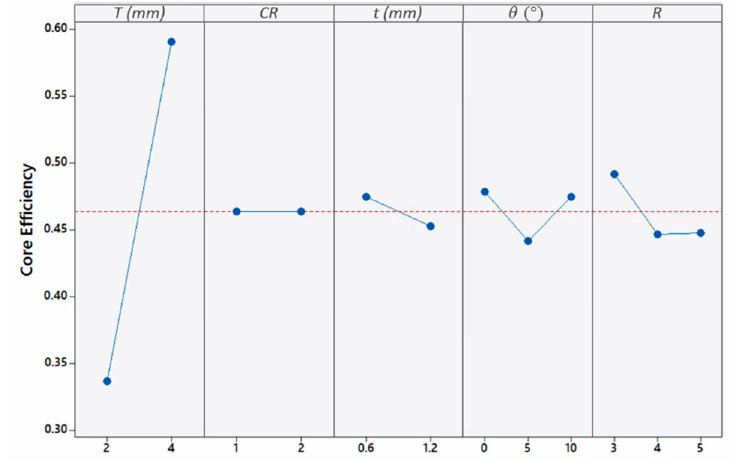
Figure 20. Dependence of Energy Absorption on the interaction of top-plate and tube thicknesses.